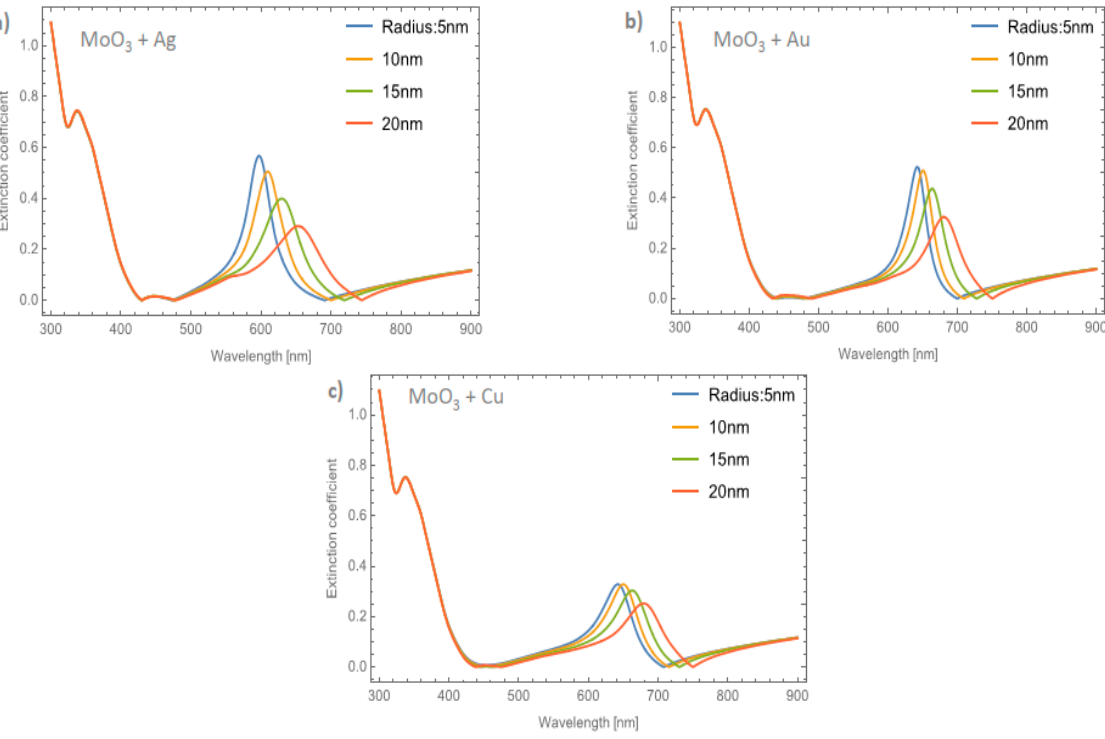
Figure 8. The extinction coefficient of the MoO 3 thin film doped with ( a ) Ag-NPs, ( b ) Au-NPs, and ( c ) Cu-NPs for a volume filling fraction of 1%. In all spectra, the thickness was fixed to a value of 120 nm, and different NPs radii are labeled.